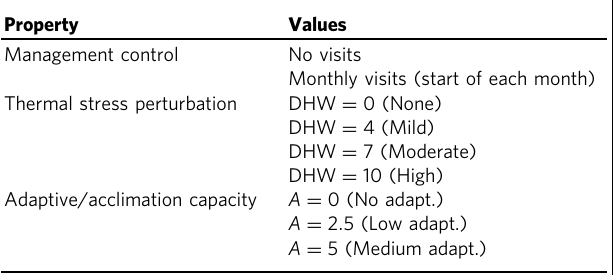
Table 2 Summary of modelled